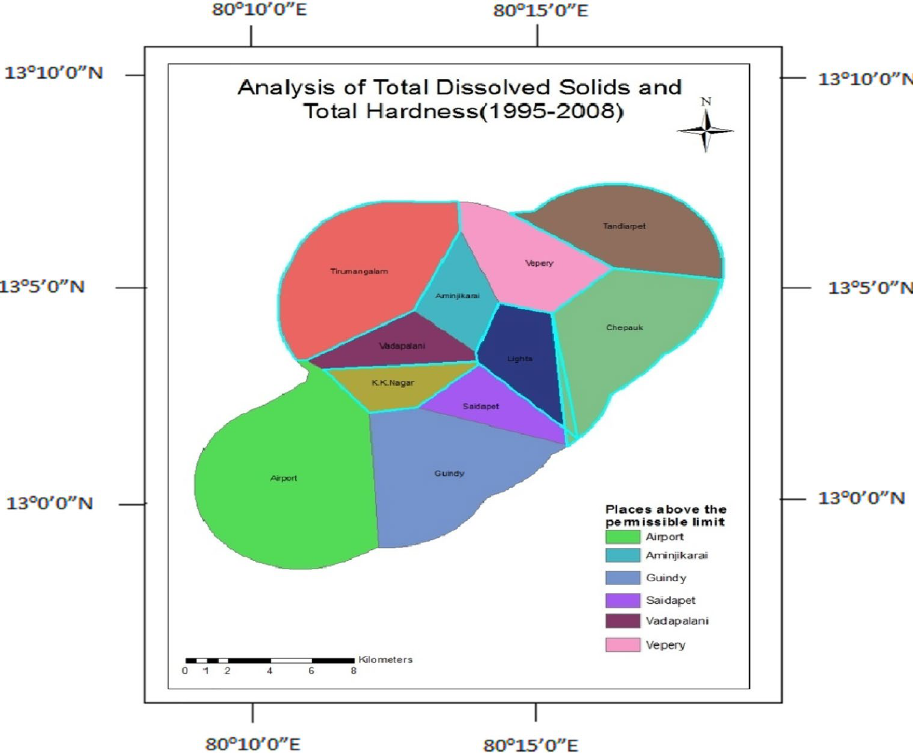
Figure 11. Analysis of total dissolved solids and total hardness for 1995–2008.